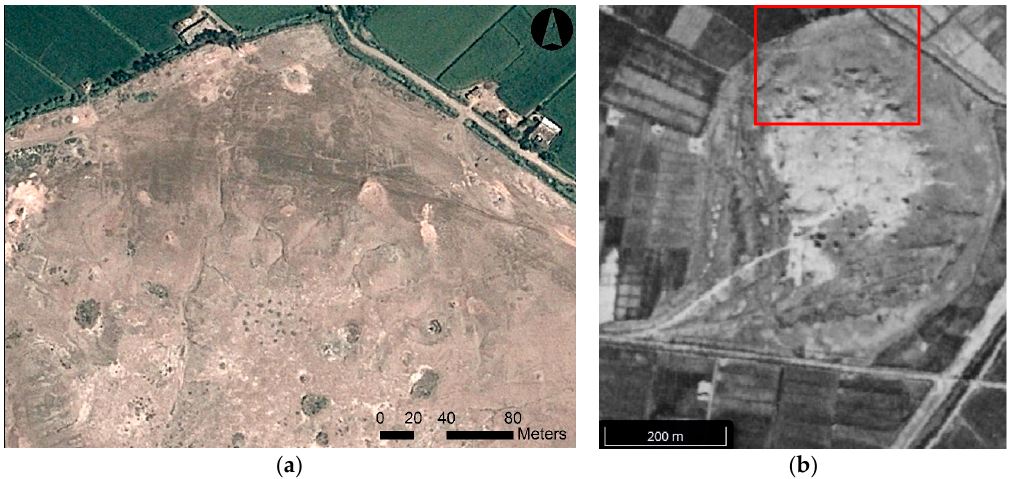
Figure 22. ( a ) The site of Tell Mutubis. Image courtesy Google Earth; ( b ) 1968 CORONA image. The area of image ( a ) is in the red box. Image courtesy of the Center for Advanced Spatial Technologies, University of Arkansas/U.S. Geological Survey.